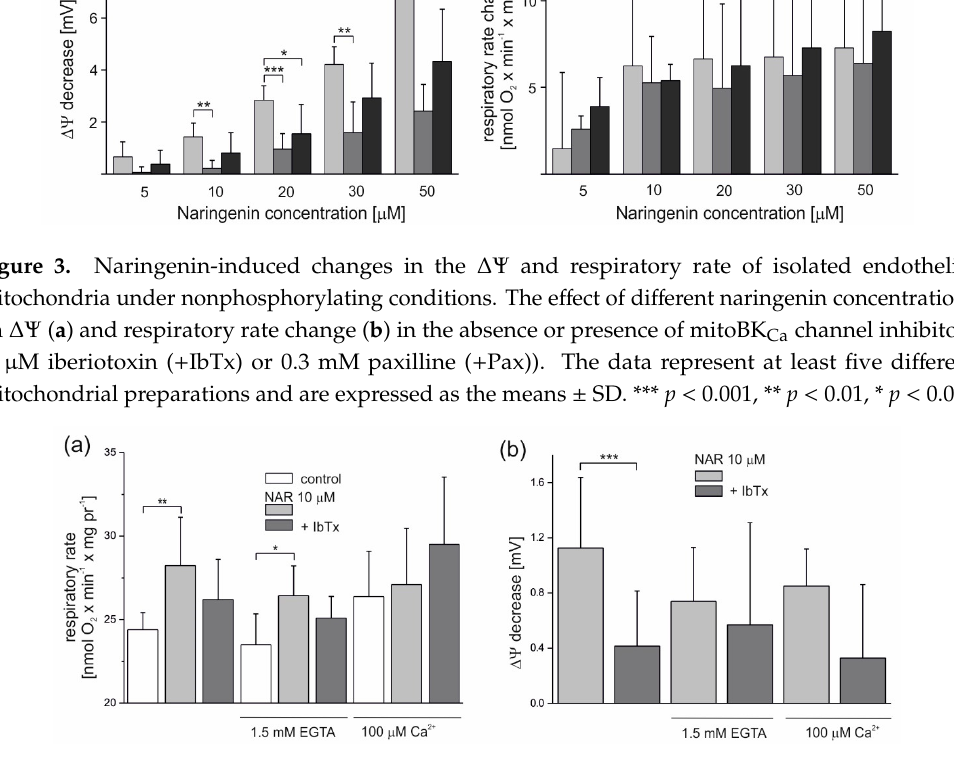
Figure 4. Influence of naringenin on the oxygen consumption rate and ∆ Ψ of isolated endothelial mitochondria under nonphosphorylating conditions. E ff ect of 10 µ M naringenin on mitochondrial oxygen consumption rate ( a ) and ∆Ψ ( b ) under control conditions (control) and in the absence or presence of 2 µ M iberiotoxin ( + IbTx). The Ca 2 + concentration was modulated by the addition of 1.5 mM ethylene glycol tetraacetic acid (EGTA) or 100 µ M Ca 2 + to the incubation medium, as indicated. The data represent at least five di ff erent mitochondrial preparations and are expressed as the means ±